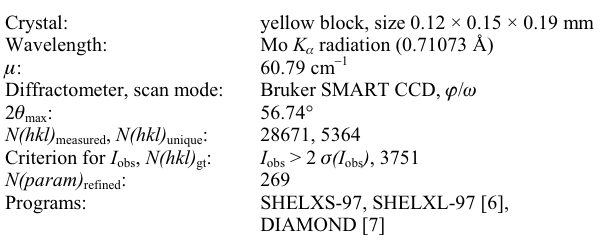
Table 1. Data collection and handling.